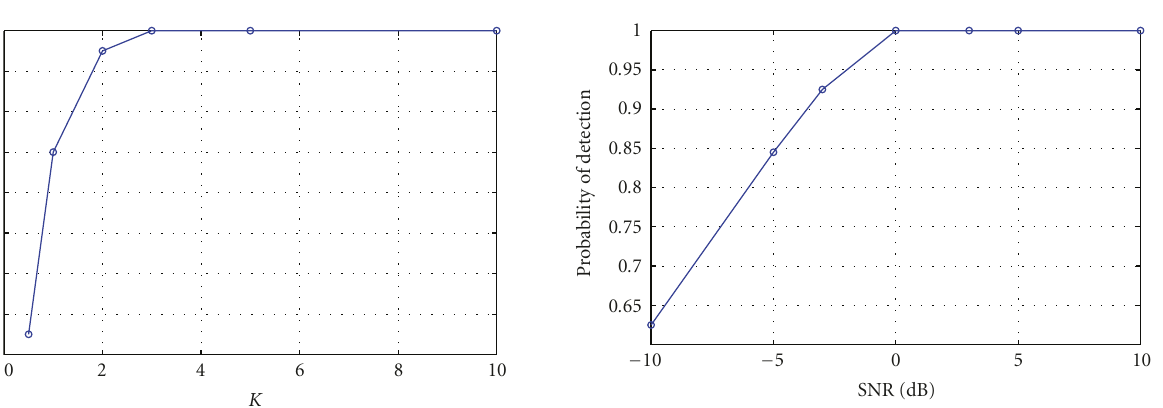
Figure 12: Probability of detection versus SNR for N SLOT = 500, K 0 = 10, and v =